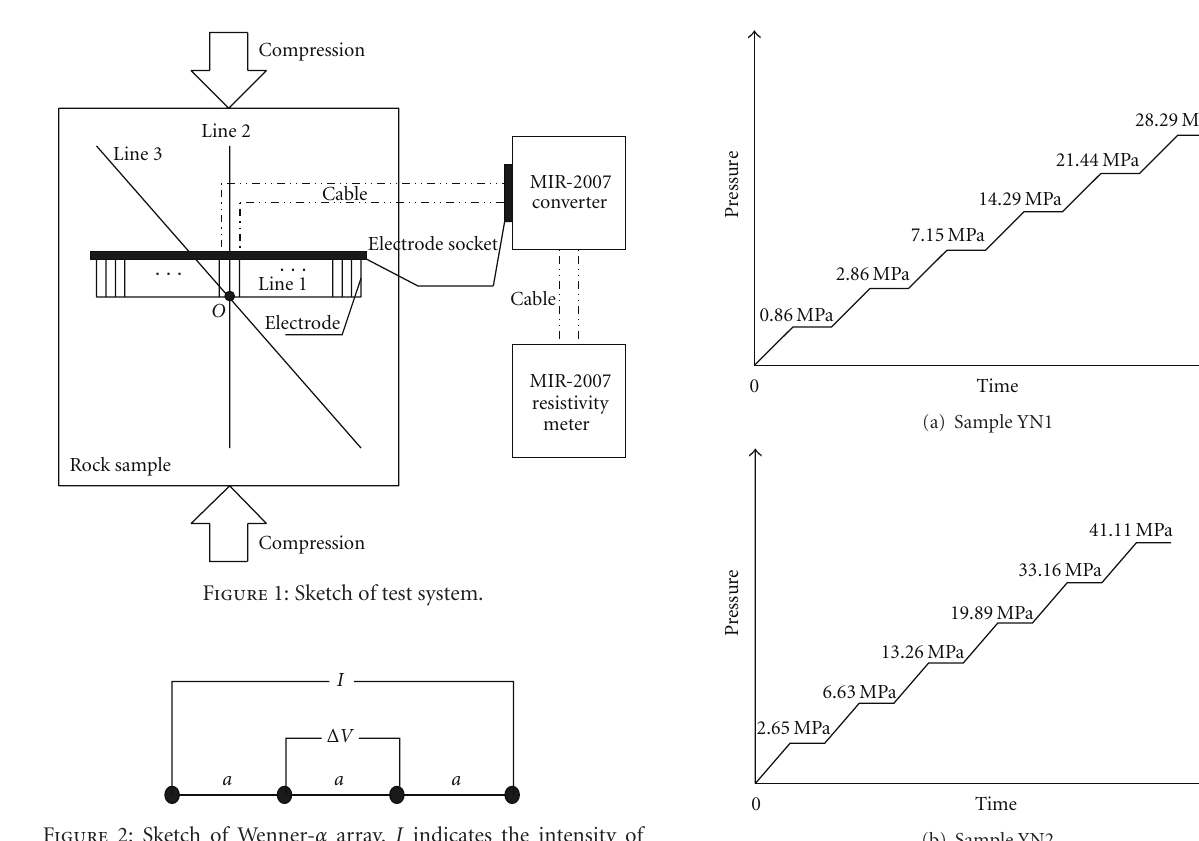
Figure 2: Sketch of Wenner- α array. I indicates the intensity of current between two current electrodes A and B . Δ V indicates the potential di ff erence between two potential electrodes M and N . Figure 3: The loading curves of